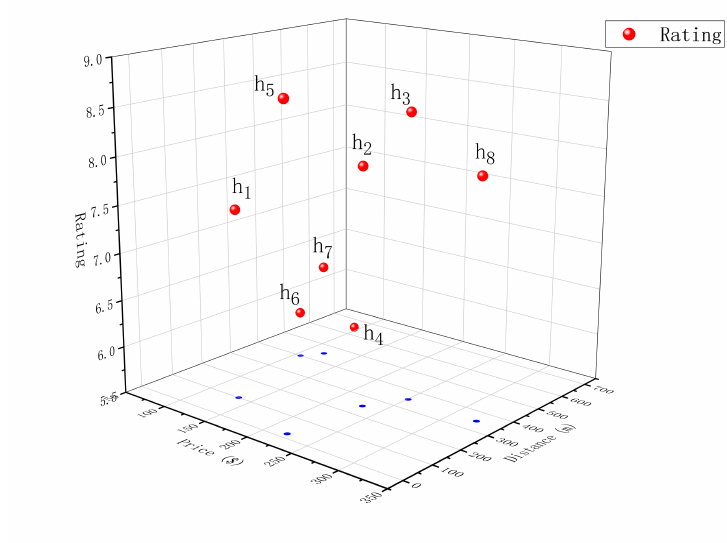
Figure 8. An example where d = 3 and w (cid:54)∈ R